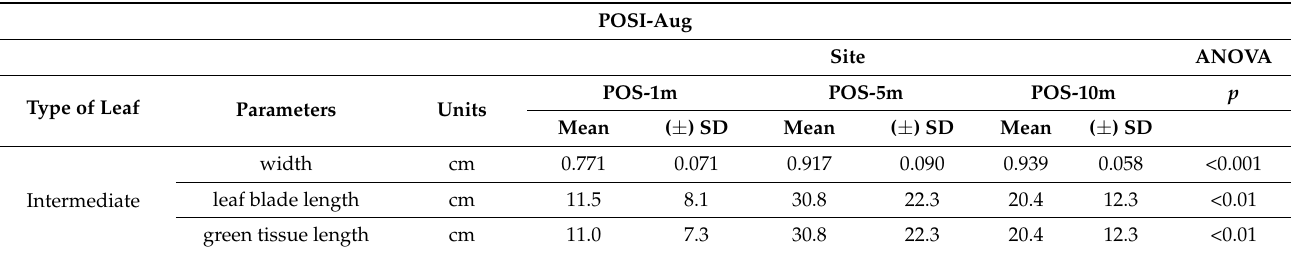
Table 2. Morphometric parameters of P. oceanica sampled during POSI-Aug at three stations, POS-1m, POS-5m andPOS-10m, at 1,5, and 10 m depth, respectively. Parameters are classified as [77] and shown as representative for each site. * Density is referred to August